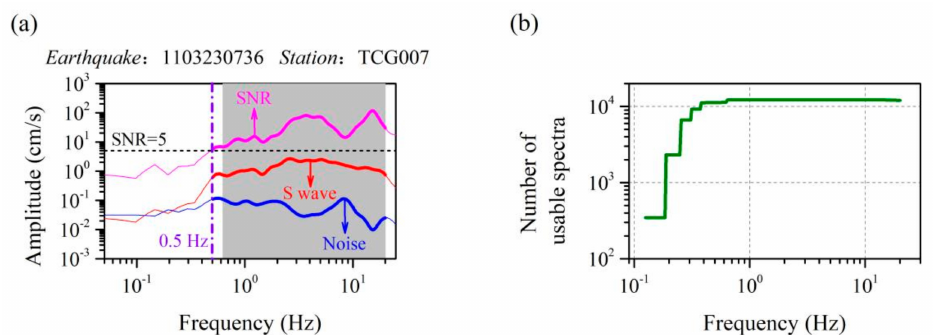
Figure 3. ( a ) The Fourier amplitude spectra for the extracted S wave (red solid line) and the pre-P wave noise window (blue solid line), and calculated signal-to-noise (SNR) (pink solid line). The shaded area indicates the usable frequency band determined according to the 1.25 f hc and SNR.